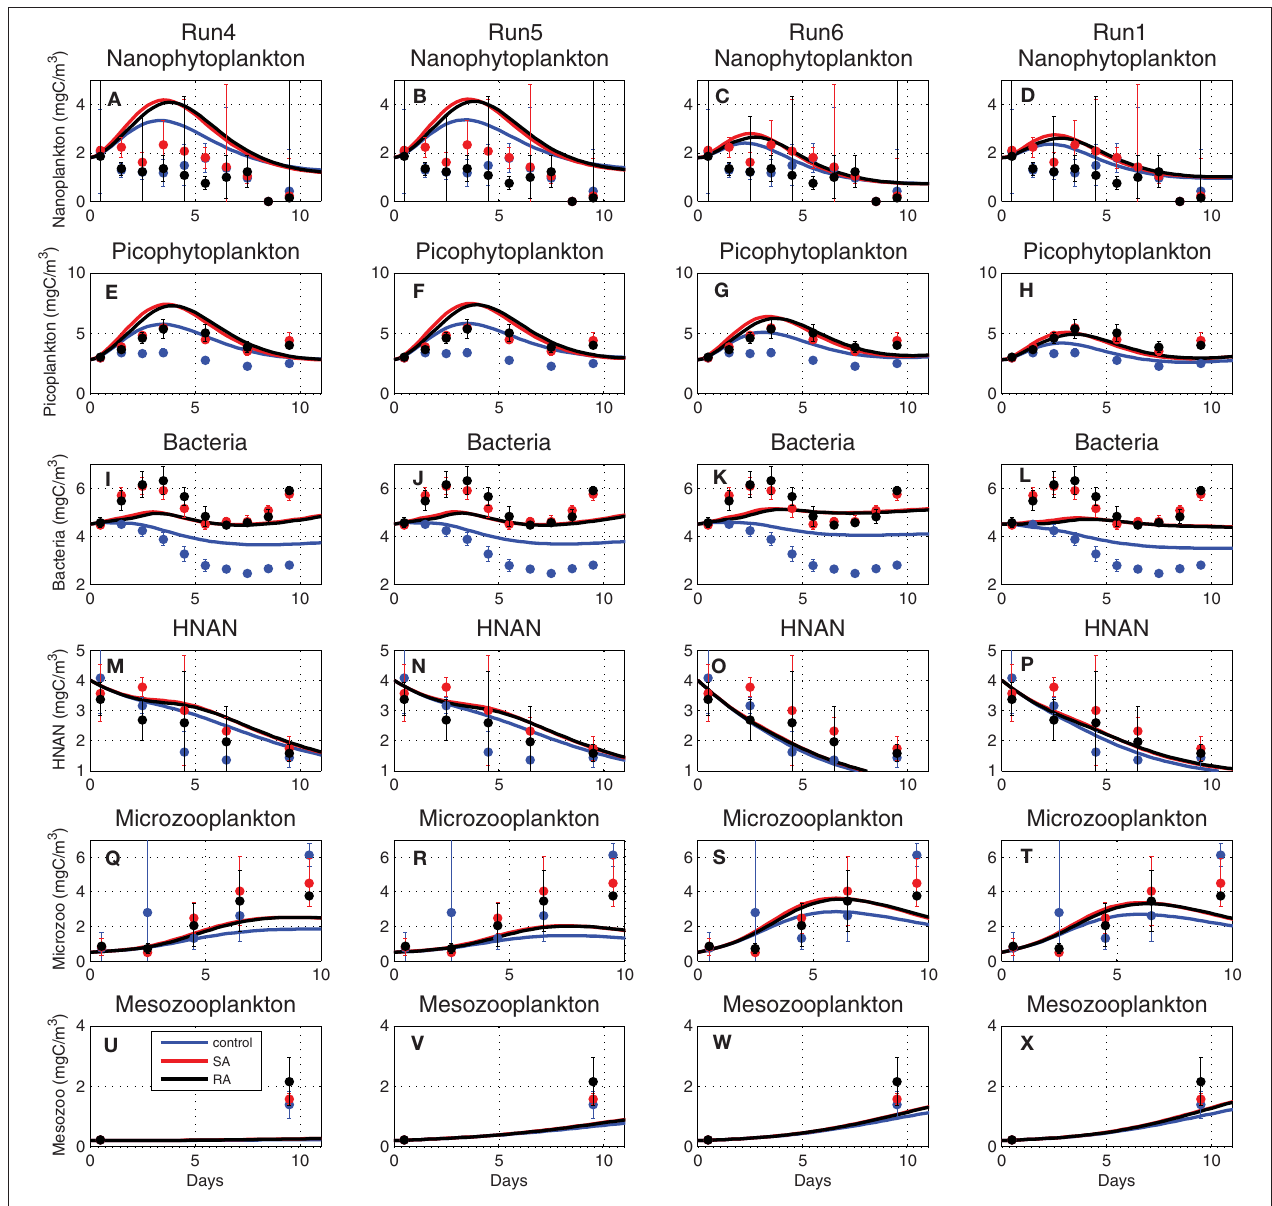
FIGURE 9 | Evolution of (A–D) nanophytoplankton, (E–H) picophytoplankton, (I–L) bacteria, (M–P) HNAN, (Q–T) microzooplankton, and (U–X) mesozooplankton biomass (mgC/m 3 ) simulated by Run4, Run5, Run6, and Run1, adopting different half-saturation constants for zooplankton uptake (see Table 1 for simulations